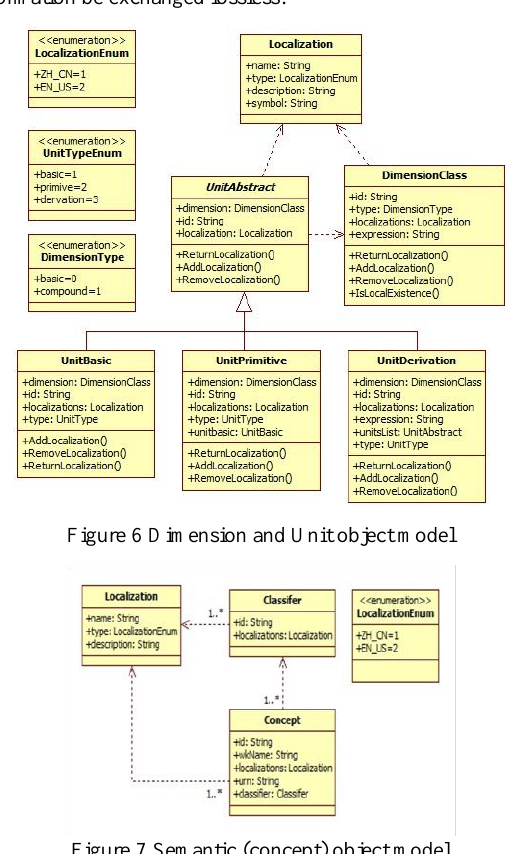
Figure 7 Semantic (concept) object model